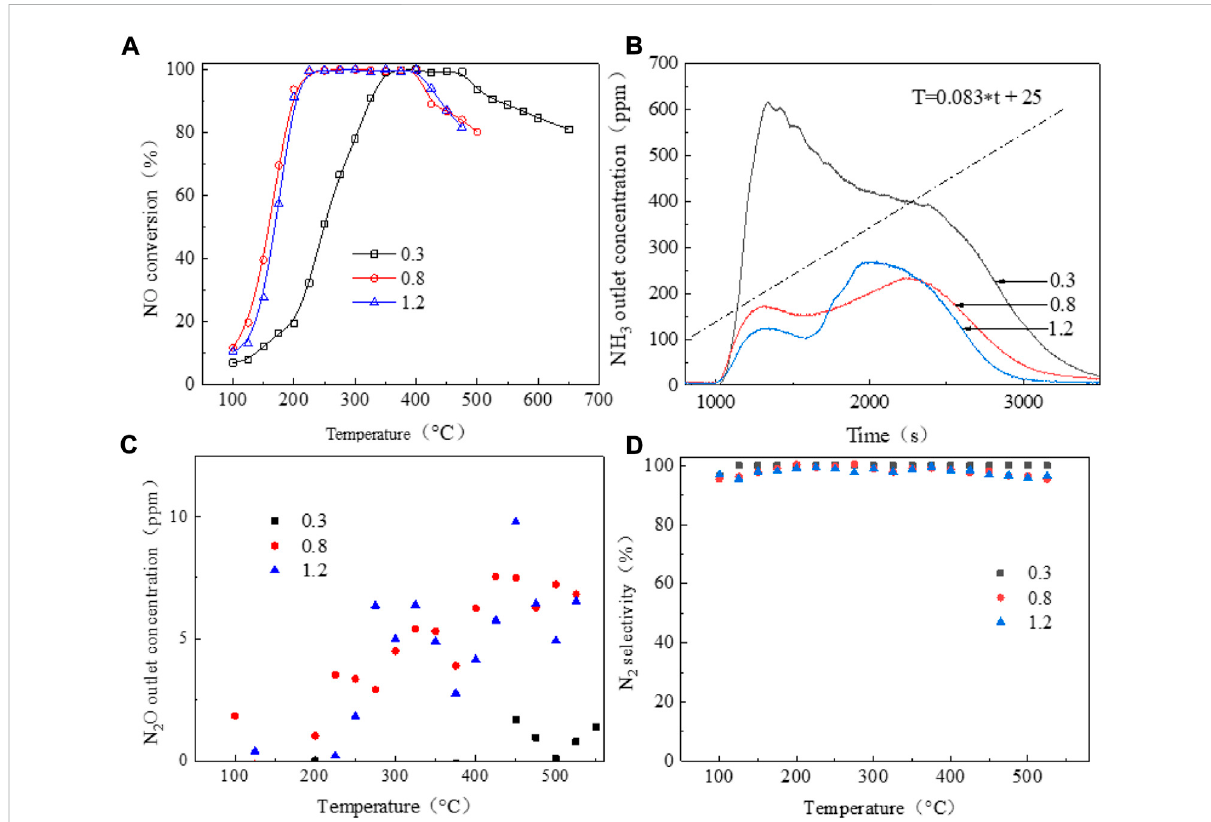
FIGURE 2 NH 3 -SCR performance of a series of copper-based SCR catalysts. (A) No conversion; (B) NH 3 outlet concentration; (C) N 2 O outlet concentration; (D)